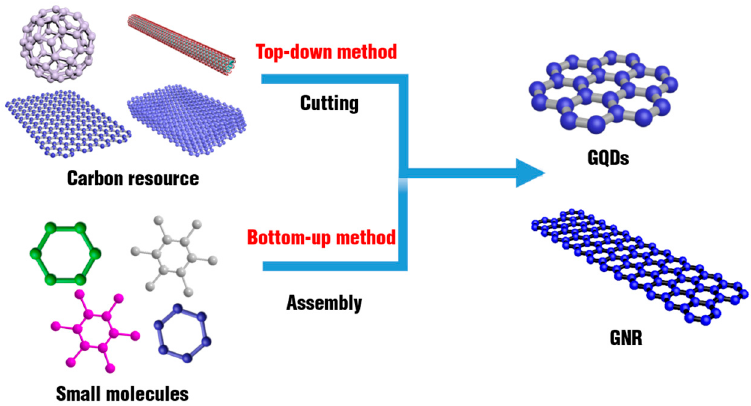
Figure 3. Schematic diagram of the top-down and bottom-up methods for synthesizing GQDs and GNRs.